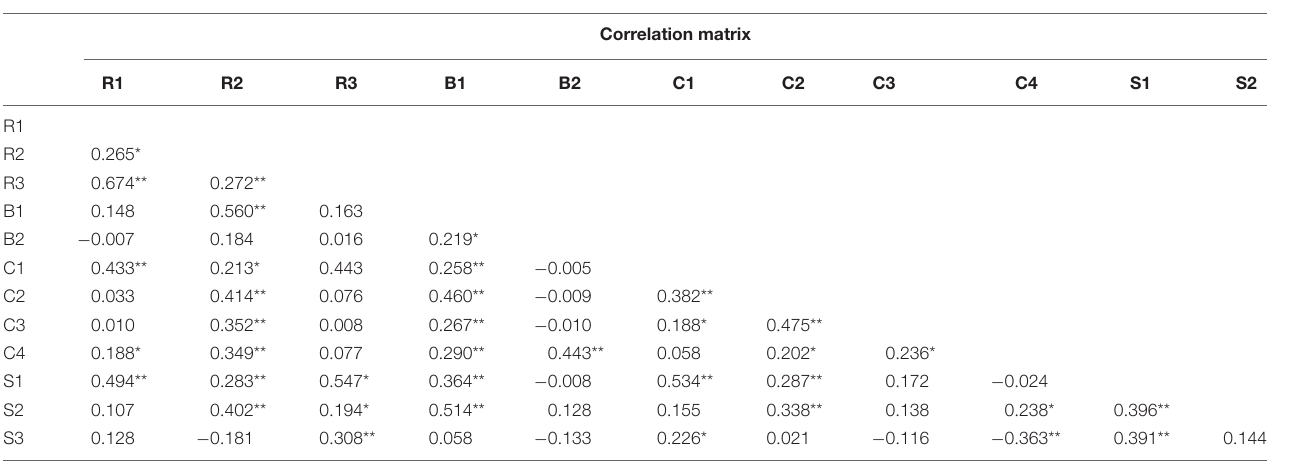
TABLE 5 | Correlations among research-use